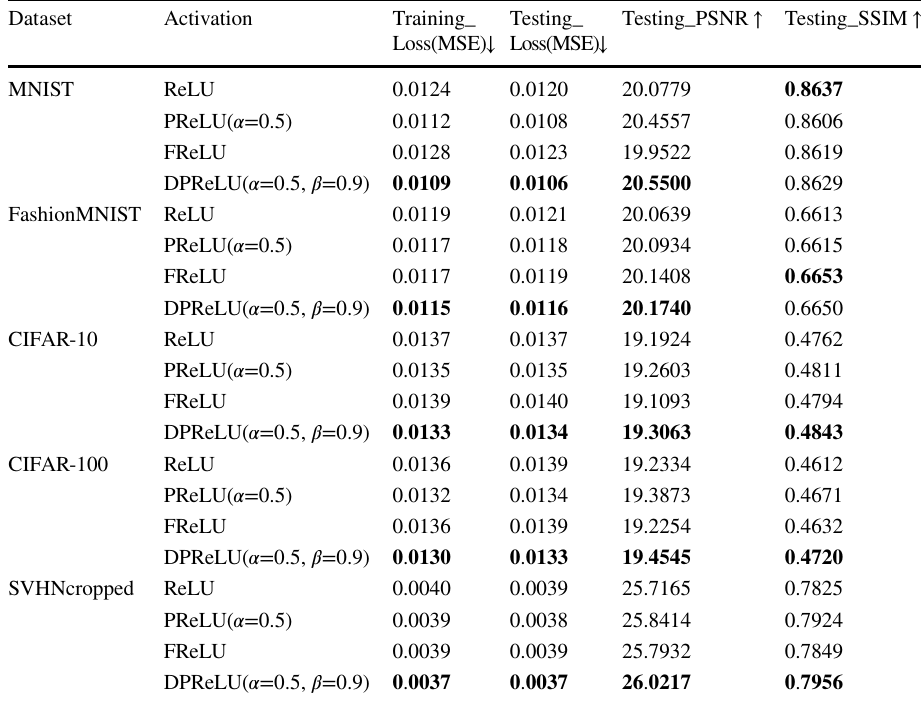
Table 3 Best performance of the autoencoder models using each activation with corresponding weight initialization on various image